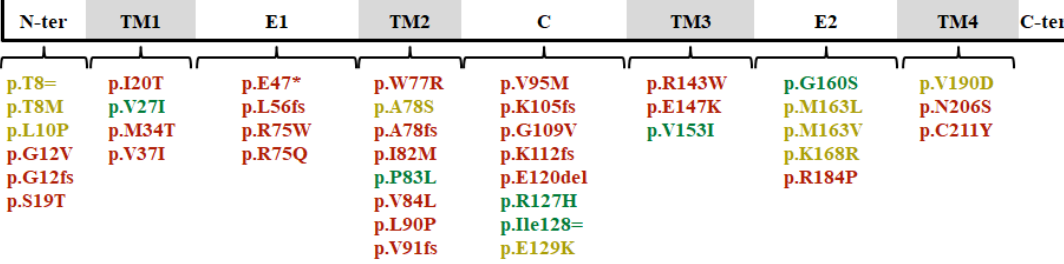
Figure 3. Distribution of coding genetic variants in connexin 26. Different colors refer to their classification after the curation process. Pathogenic and likely pathogenic variants are in red; benign and likely benign in green; uncertain significance in yellow.